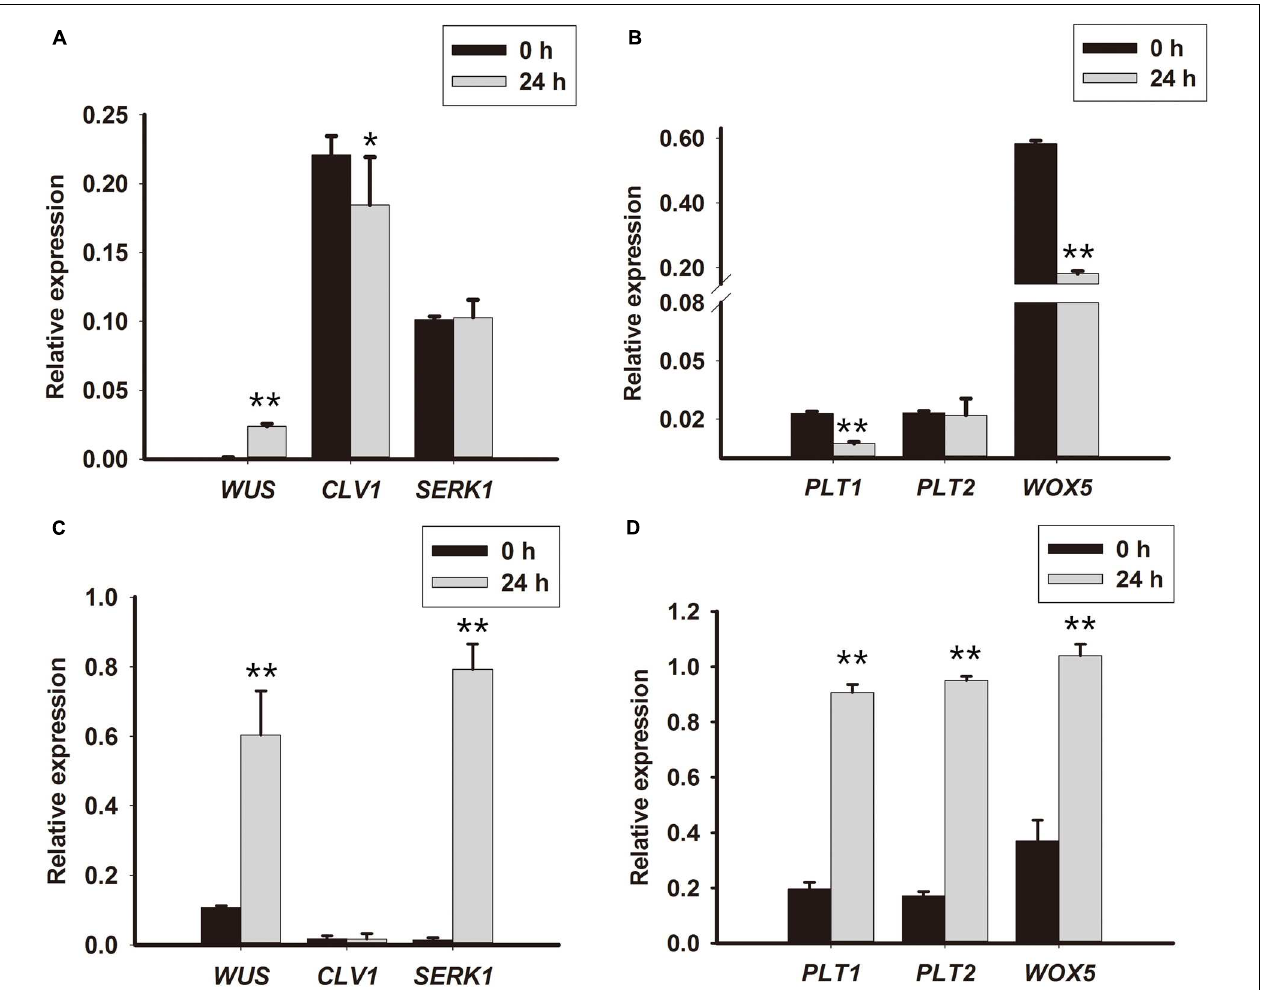
FIGURE 4 | Expression levels of root and shoot stem niche-related genes in rhizoid tips. Callus-rhizoids (0.1–0.2 g fresh) and rhizoids were collected after culture on PIM for 0 or 24 h. Quantitative real-time PCR was used to analyze genes expression levels. (A,B) Gene expression in callus-rhizoids. (C,D) Gene expression in rhizoid tips. Error bars represent the SE of three biological replicates. Asterisks indicate significant ( ∗ P < 0.05) or highly significant ( ∗∗ P < 0.01) differences calculated using the t -test ( n = 3 for each